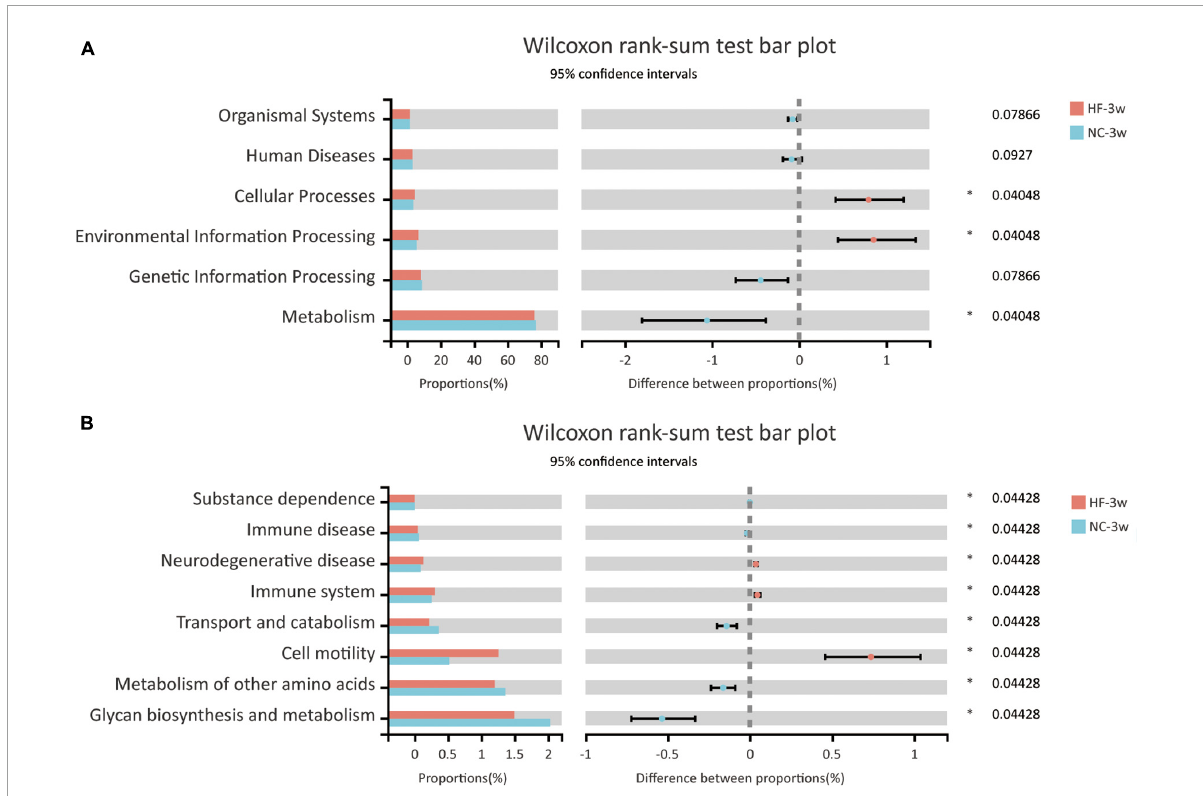
FIGURE5 Functional predictions of bacterial communities by the KEGG pathway database in offspring at weaning. (A) KEGG pathway level 1. (B) KEGG pathway level 2 (NC-3w, n = 6; HF-3w, n = 6). ∗ p < 0.05 vs. NC-3w. NC, normal chow diet; HF, high-fat